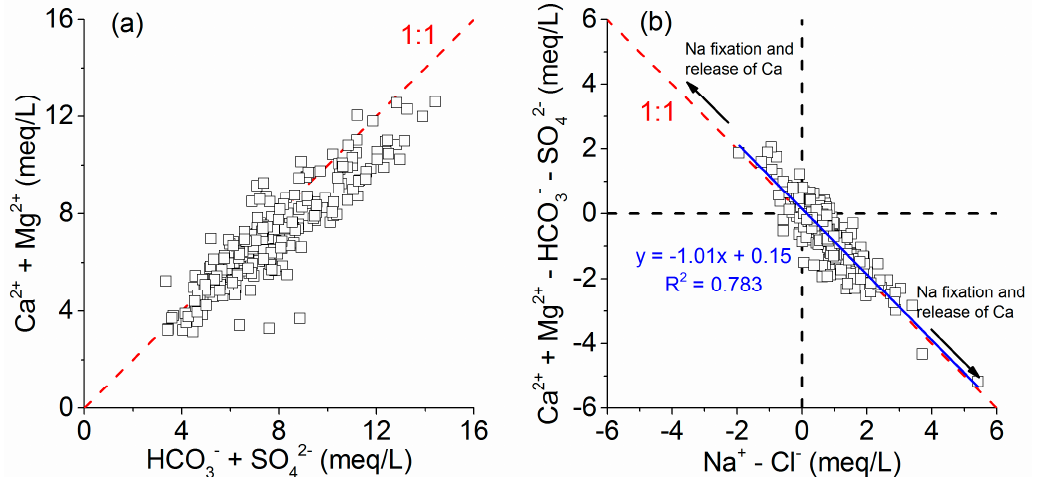
Figure 6. Multivariate diagrams of carbonate and sulfate weathering and dissolution ( a ), cation exchange ( b ).